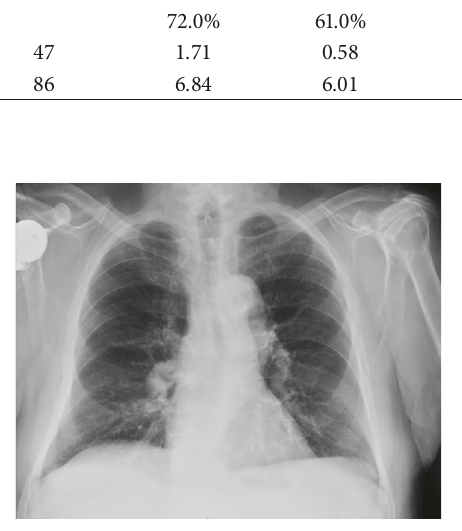
Figure 4: Chest X-ray 1 year